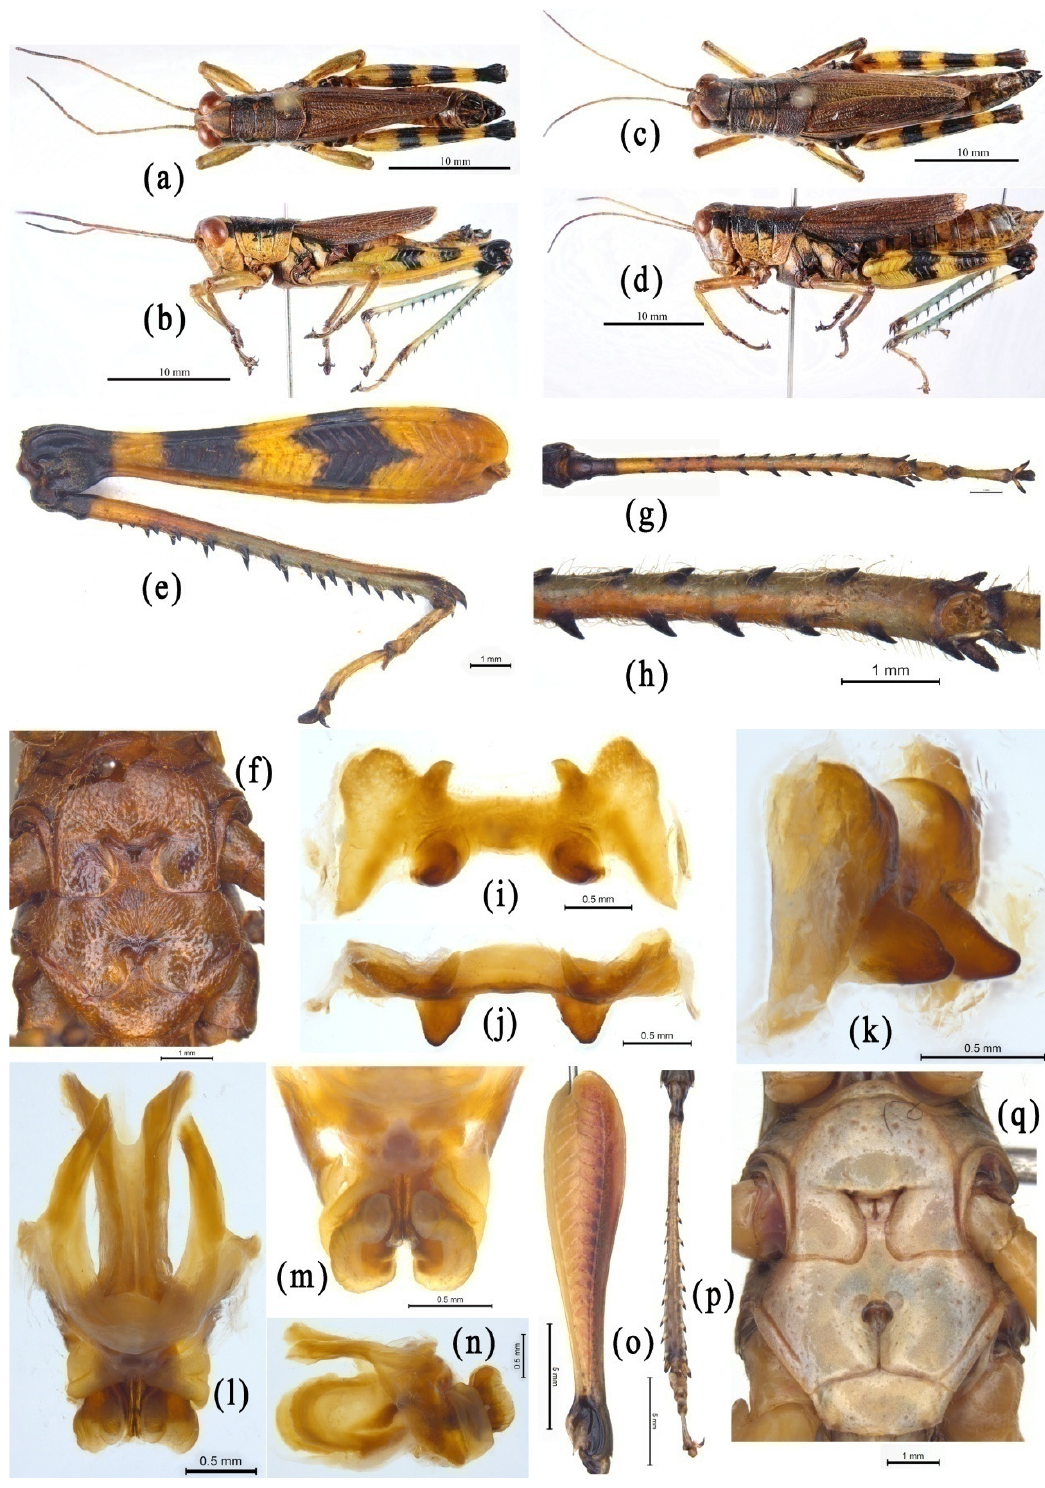
Figure 4. Morphological characters of Emeiacris maculata and Oxya agavisa . ( a – n ) Emeiacris maculata . ( a , b ) Male habitus. ( c , d ) Female habitus. ( e ) Right hind leg of male. ( f ) Meso- and metasterna of male. ( g , h ) Right hind tabia of male. ( i – k ) Epiphallus in dorsal, frontal and dorsolateral views. ( l – n ) Phallic complex in dorsal and lateral views. ( o – q ) Oxya agavisa . ( o ) left hind femur of male. ( p ) left hind tibia of male. ( q ) Meso- and metasterna of male.